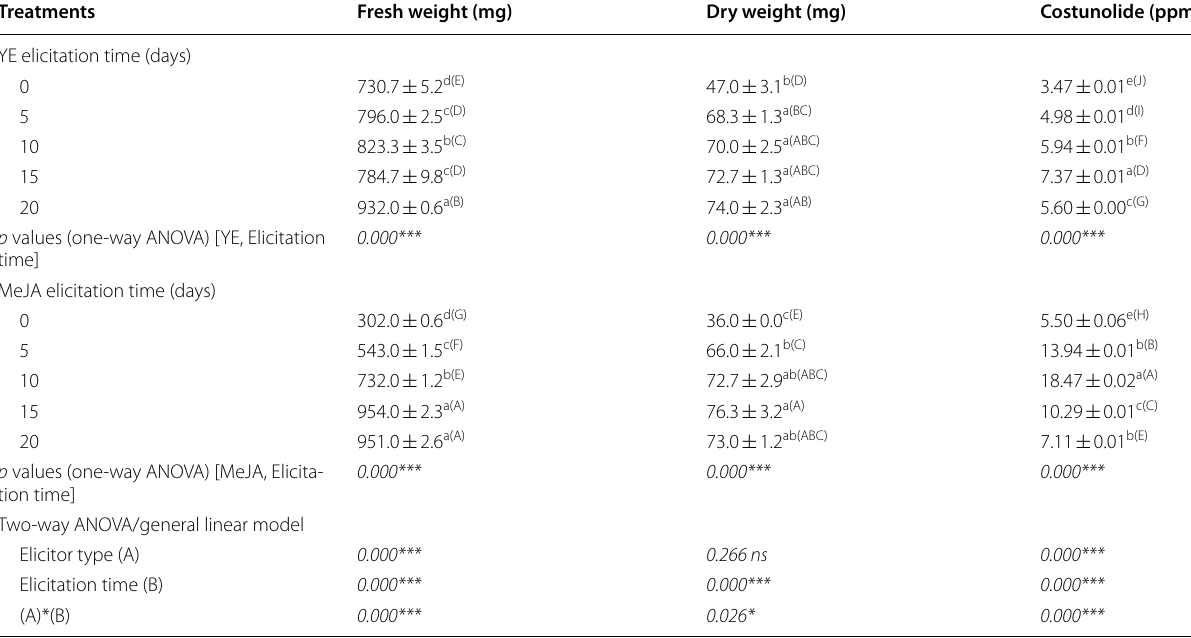
Table 3 Effect of elicitation time combined with 200 mg/L YE or 150 mg/L MeJA on cell growth parameters and costunolide